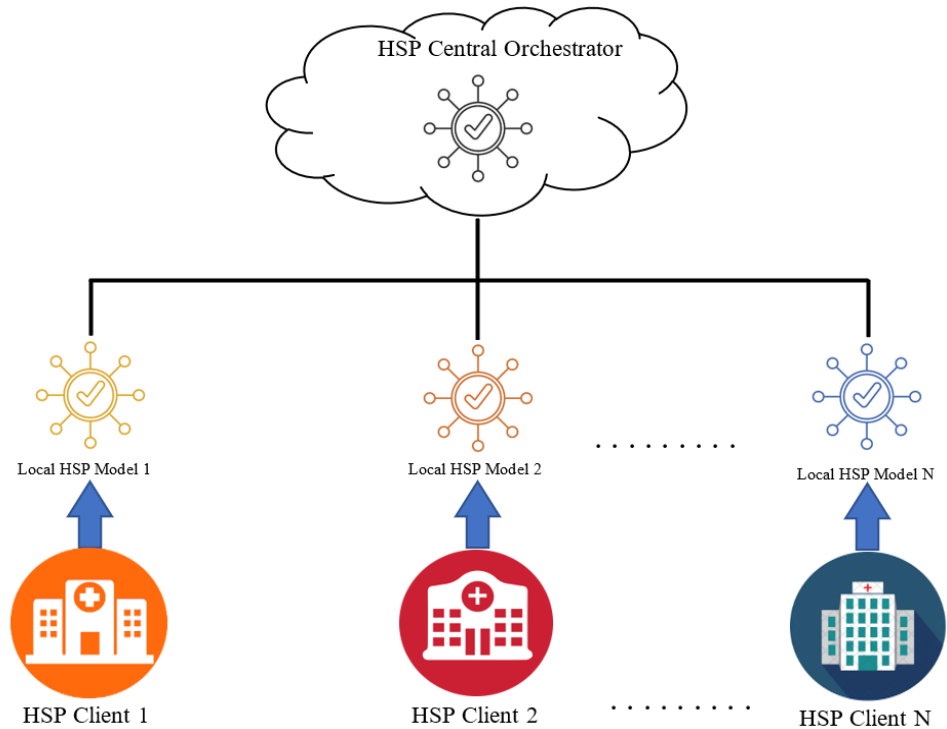
Figure 1. Overview of proposed hybrid federated learning framework.